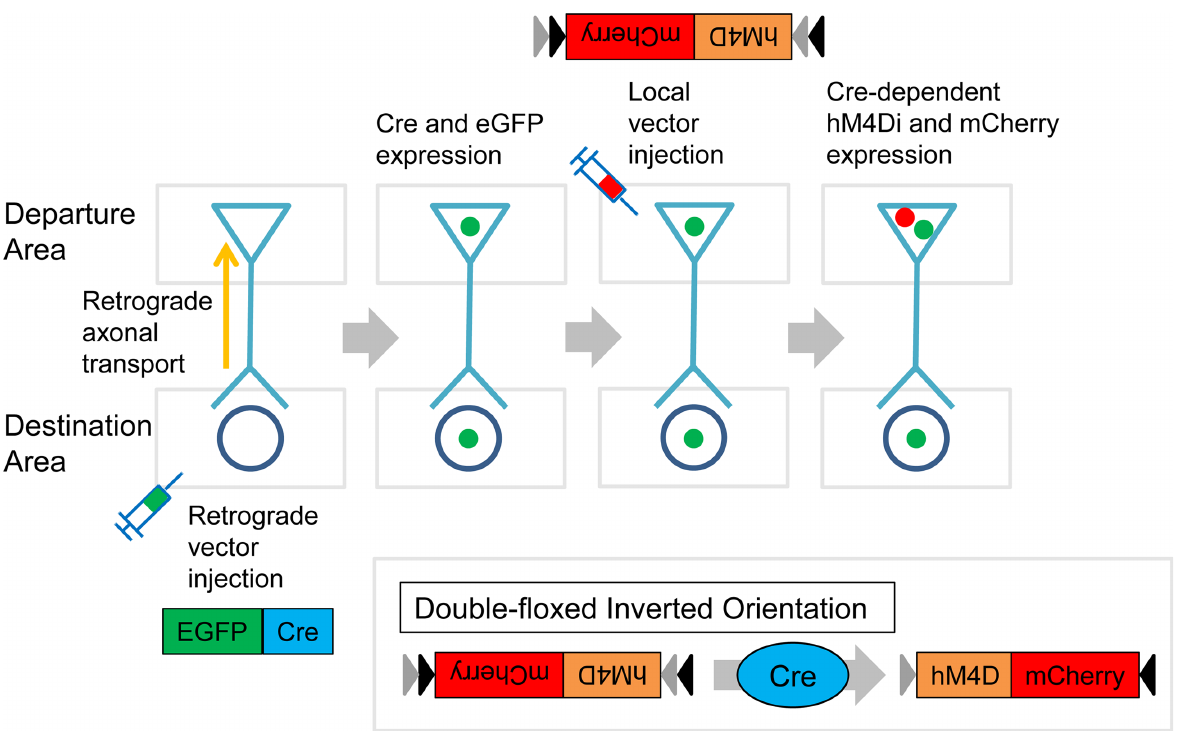
Fig 1. Schematic diagram of the pathway specific gene transfer using the double virus vector infection. The retrograde vector was injected into the destination area: where the axon terminal of the target cell was. The retrograde vector was then transported to the cell body of the target cell through axonal transport. The target cell expressed Cre and eGFP if retrogradely infected by the retrograde vector. The local vector was injected into the departure area: where the soma of the target cell was. Only doubly infected target cell expressed mCherry and possibly hM4D i because of the “ Cre-on ” system. In our study local vector and retrograde vector were alternately injected over a period of